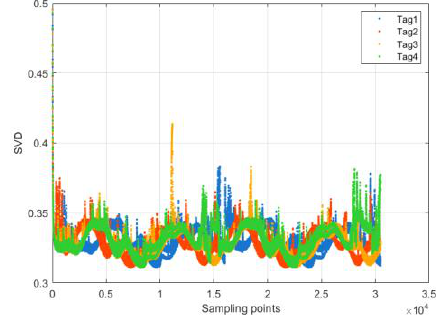
Table 1. Comparison of errors from different tags